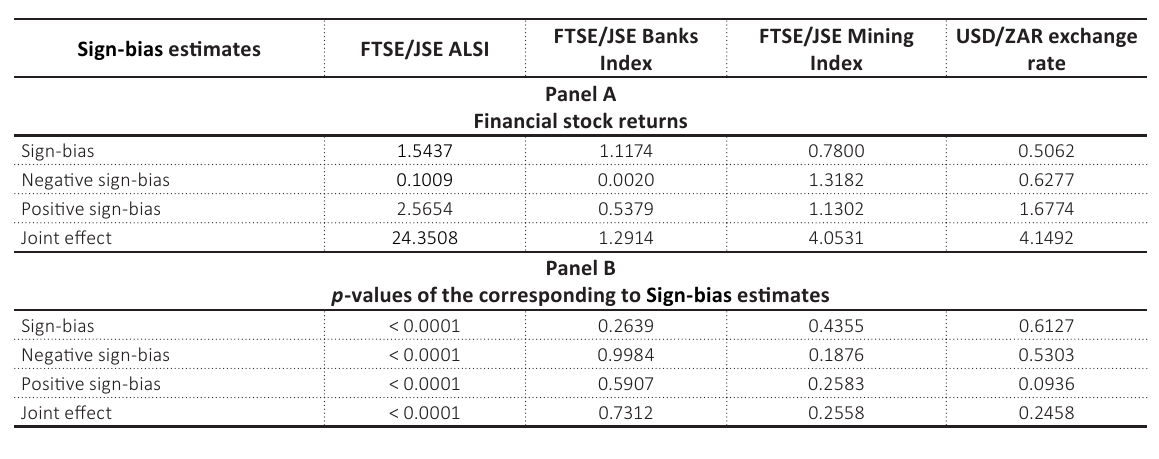
Table 3. Sign bias test of return series